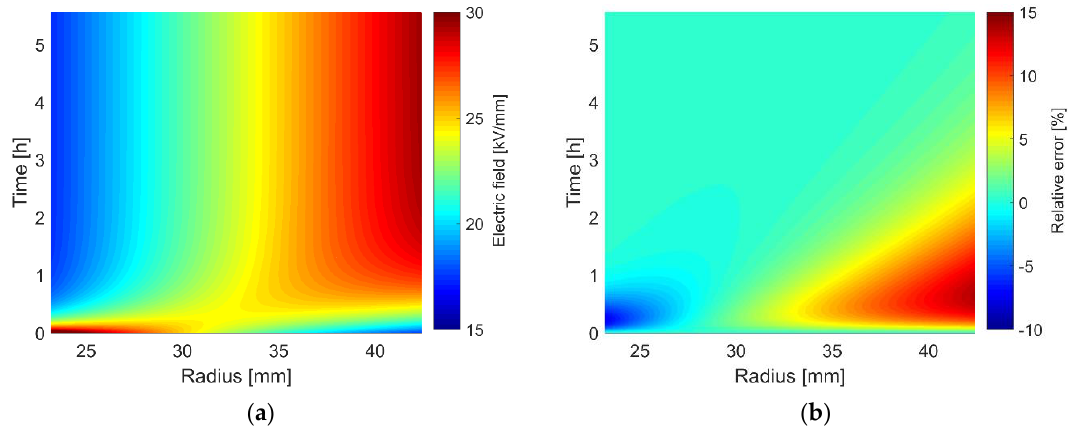
Figure 7. ( a ) Numerically computed electric field distribution; ( b ) relative error between the numerically computed transient electric field and the approximation (35).